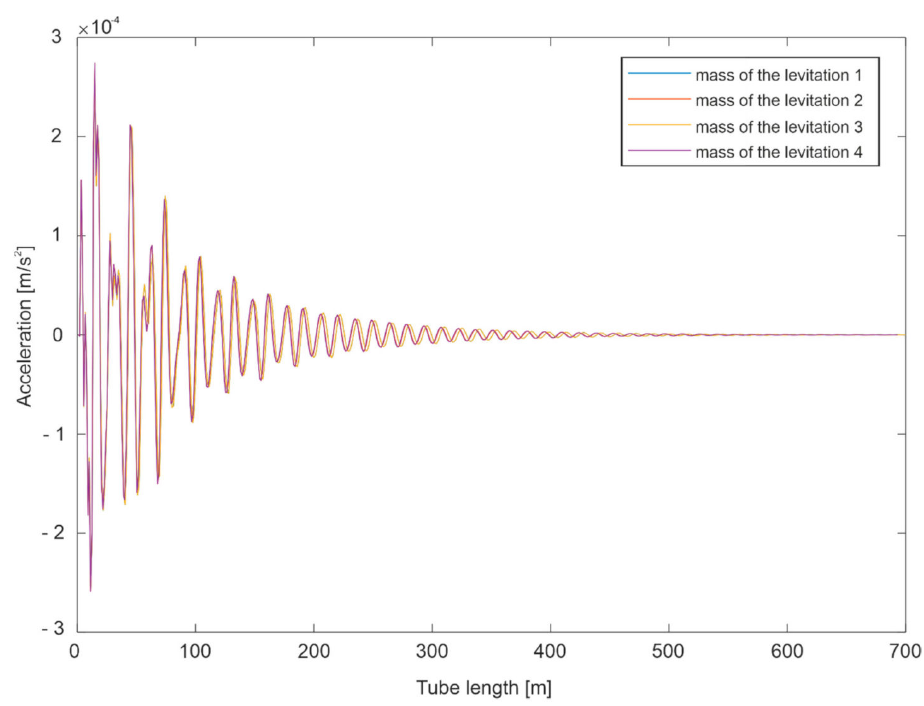
Figure 24. Acceleration on the levitation system in the direction y for 1000 km / h.